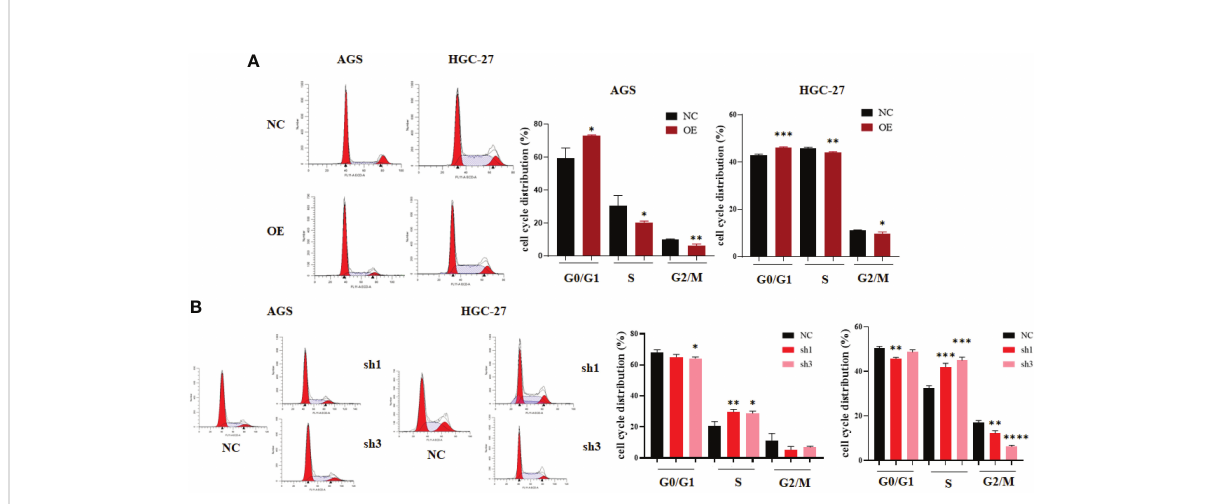
FIGURE 3 Cell cycle distribution of gastric cancer cells after upregulation and downregulation of hsa_circ_0061276. (A) Representative data of cell cycle distribution after upregulation of hsa_circ_0061276 (left) and the statistical analysis results (right). OE, expressed plasmid; NC, negative control plasmid. * p < 0.05, ** p < 0.01, *** p < 0.001, n = 3. (B) Representative cell cycle distribution after downregulation of hsa_circ_0061276 (left) and the statistical analysis results (right). NC, negative control plasmid; sh1 and sh3, short hairpin RNA plasmids; * p < 0.05, ** p < 0.01, *** p < 0.001,